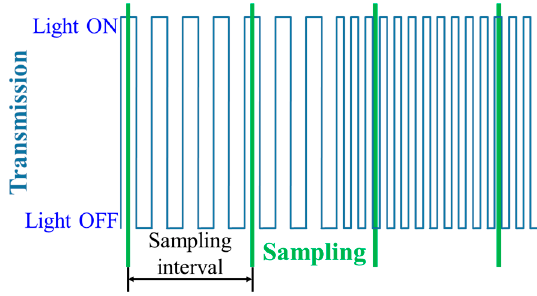
Figure 18. UFSOOK encoding of a logic “0 1” bit pattern.